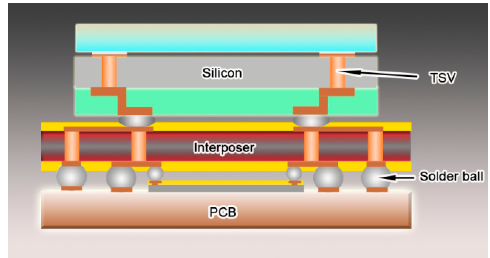
Figure 1. The illustration of through silicon via in electronic component.